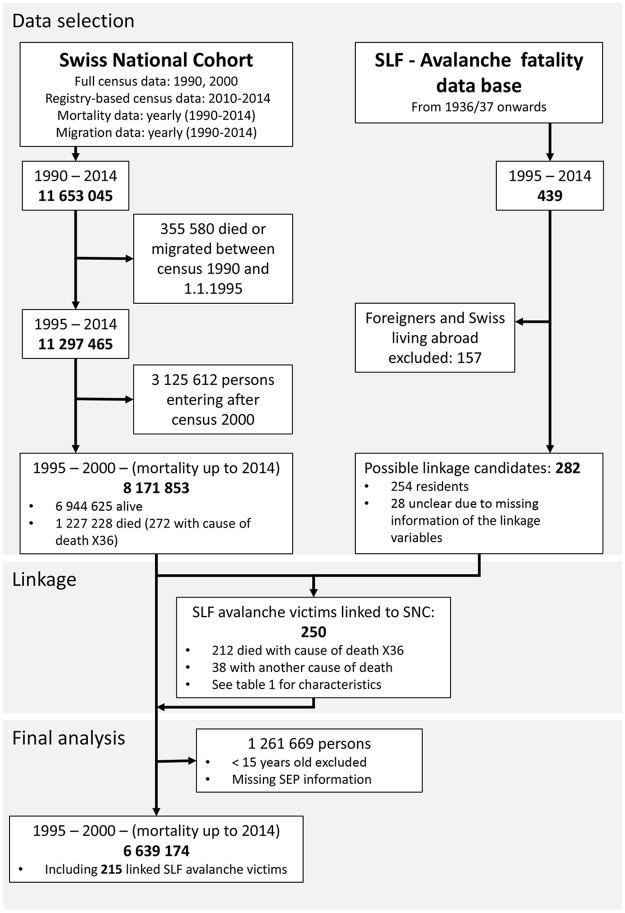
Flowchart illustrating the linkage process and selection of the study participants for the final analysis.